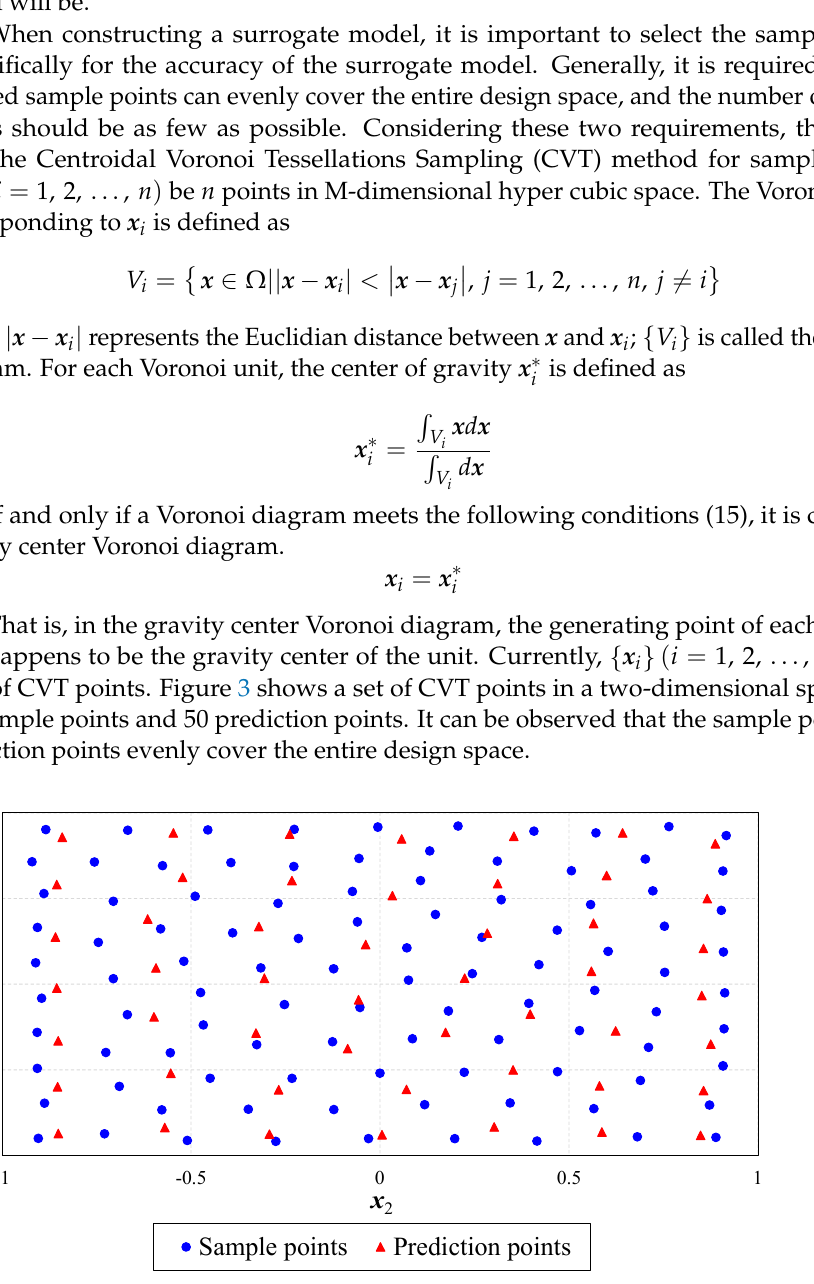
Figure 3. The CVT sampling scheme of a two−dimensional case.